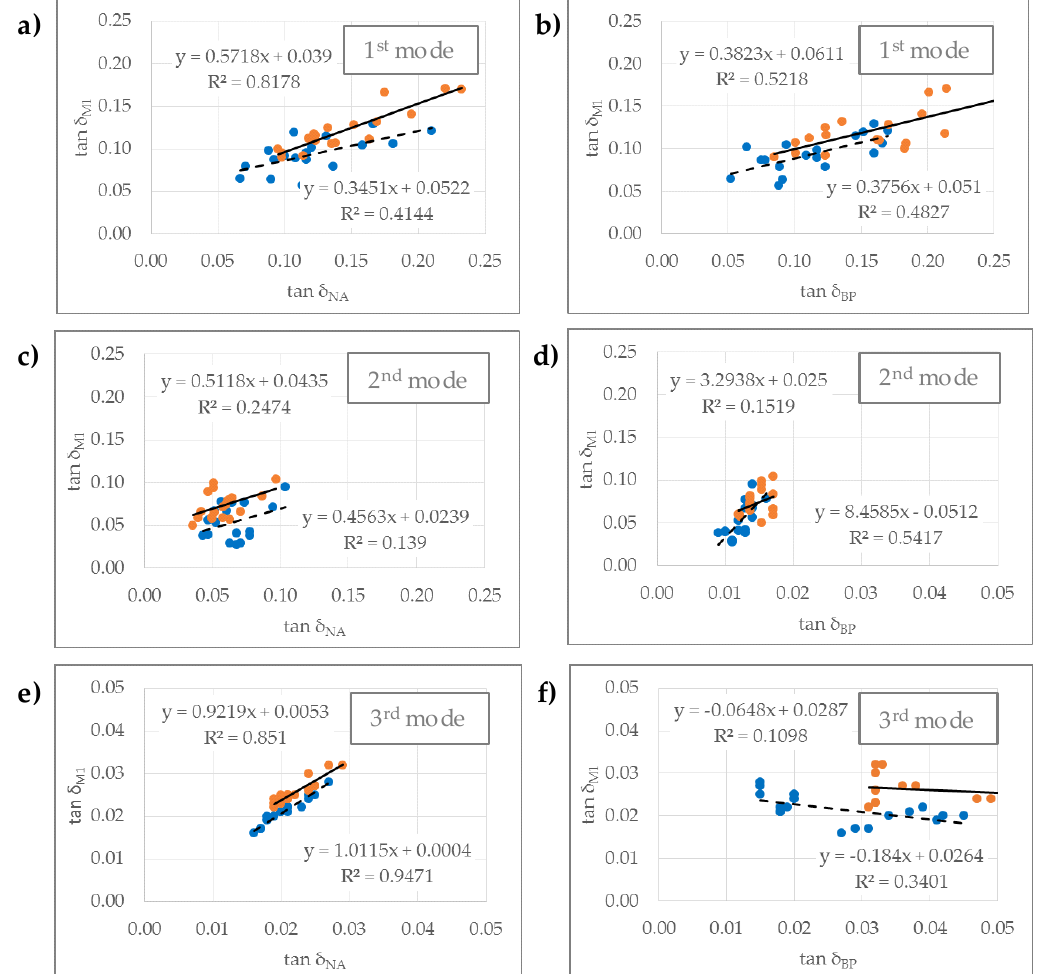
Figure 5. Correlation of damping of mechanical vibrations at the neck (NA, 8th fret) and body of the guitar (M 1 ; ( a , c , e )), and at the body of the guitar (M 1 ) and the pickup (BP; ( b , d , f )) [(ash wood ( ● ); walnut wood ( ● )].